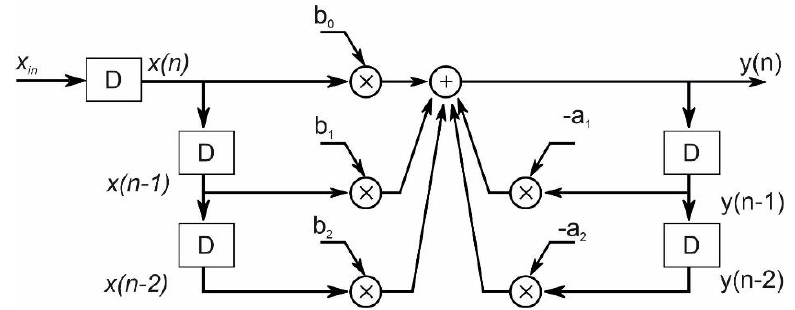
Figure 6. IIR filter direct form I structure. Table 1. IIR coefficients scaled by 9 2 and the percentage error introduced by integer rounding.